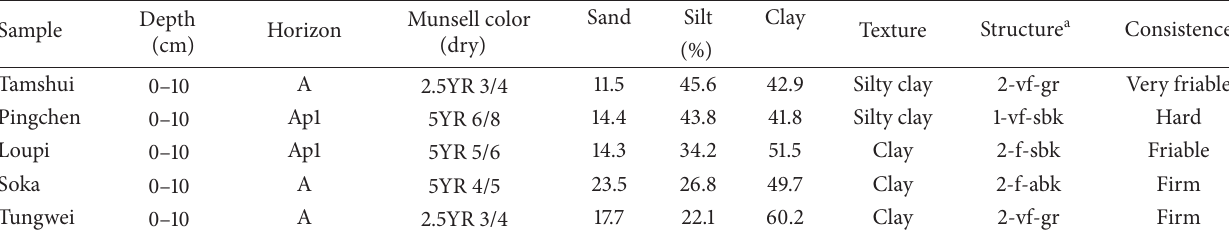
Table 2: Some physical properties of the lateritic soils being studied.